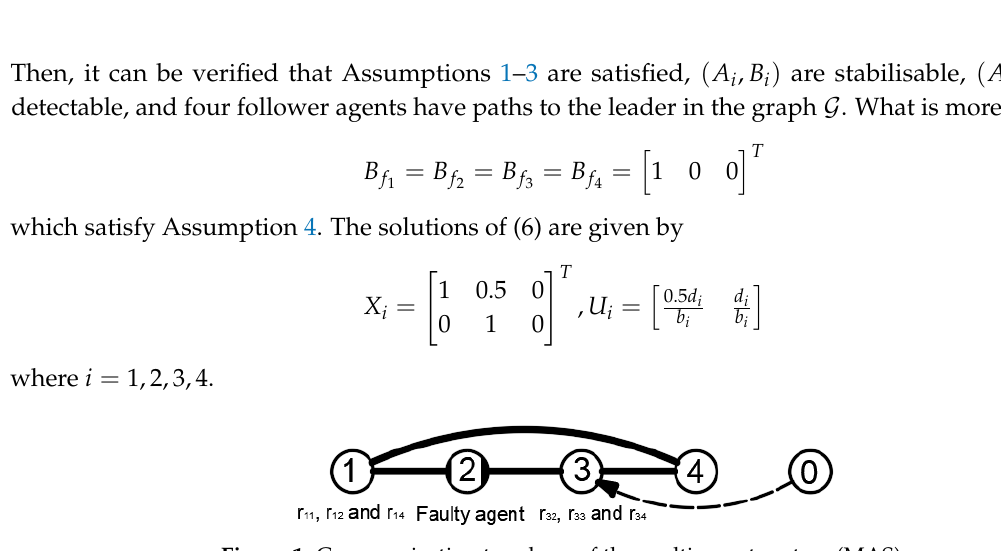
Figure 1. Communication topology of the multi-agent system (MAS).